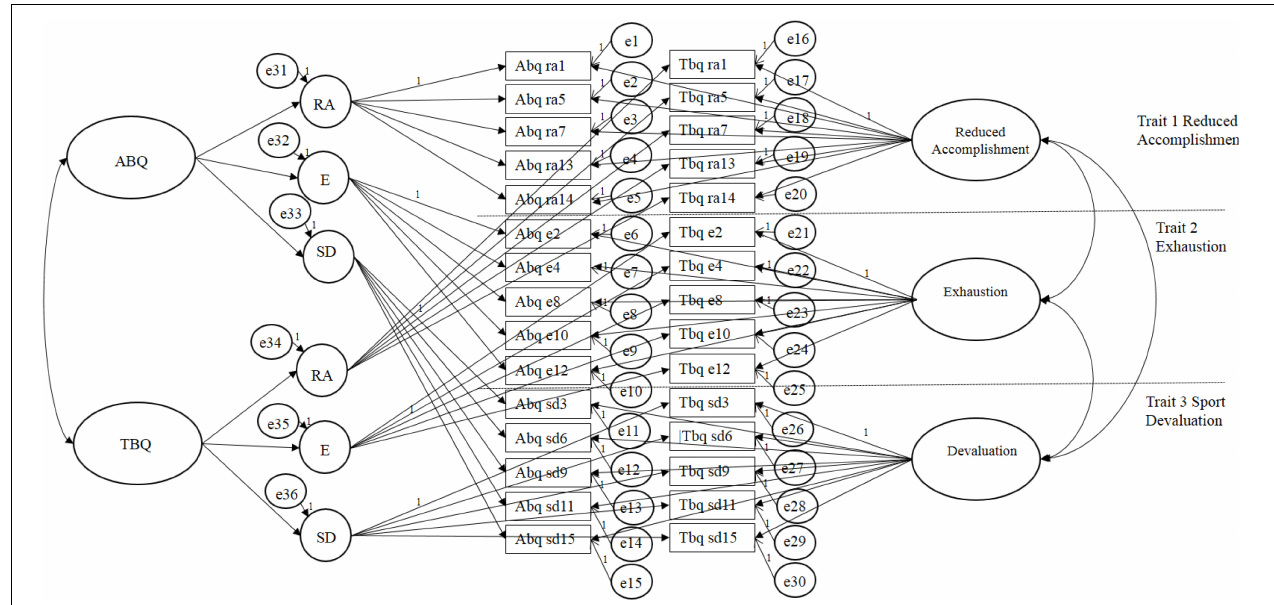
FIGURE 1 | Hypothesized MMTM model (correlated traits – correlated